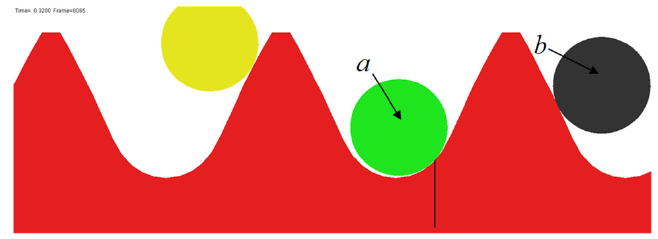
Figure 11. Simulation result of point 3. Figure 12 corresponds to the simulation result of point 4 in Figure 8. The number of simulation steps at this time is the 380nd. The moving distance of the rack is 38.000 mm at this moment, and the corresponding roller pinion angle is 36.2873°.